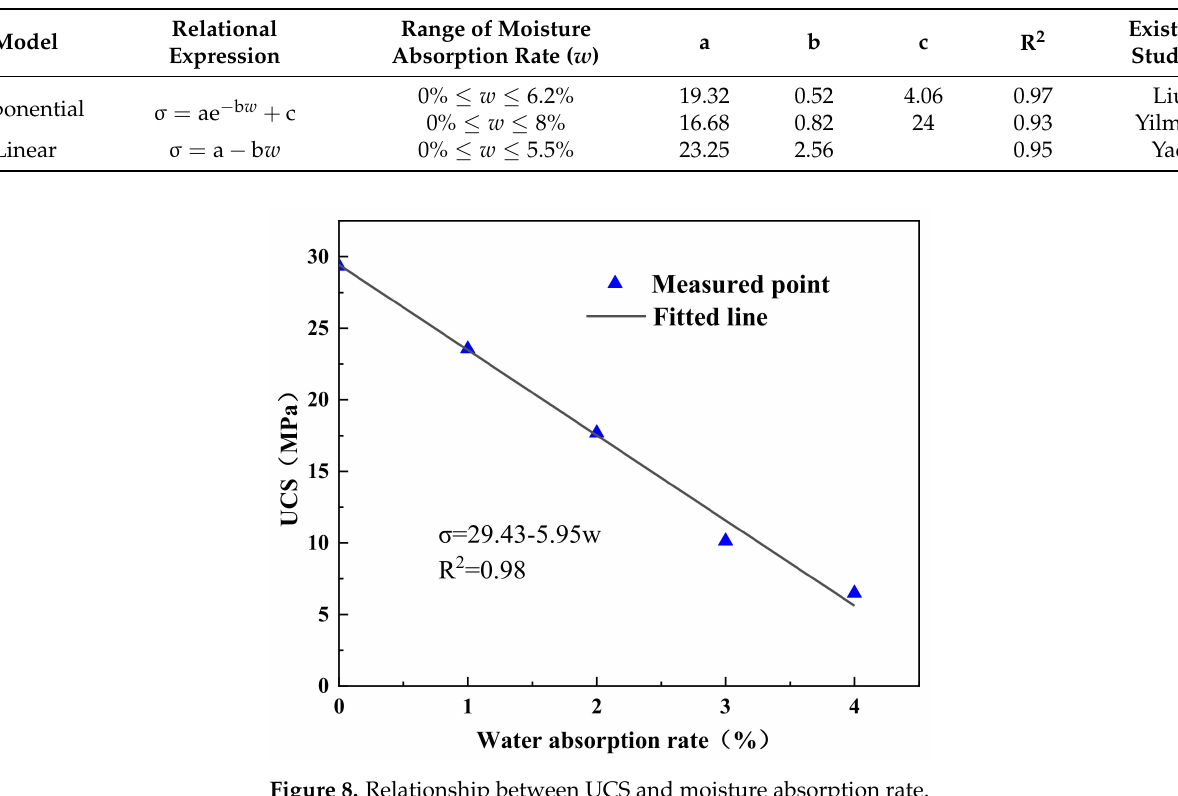
Figure 8. Relationship between UCS and moisture absorption rate.